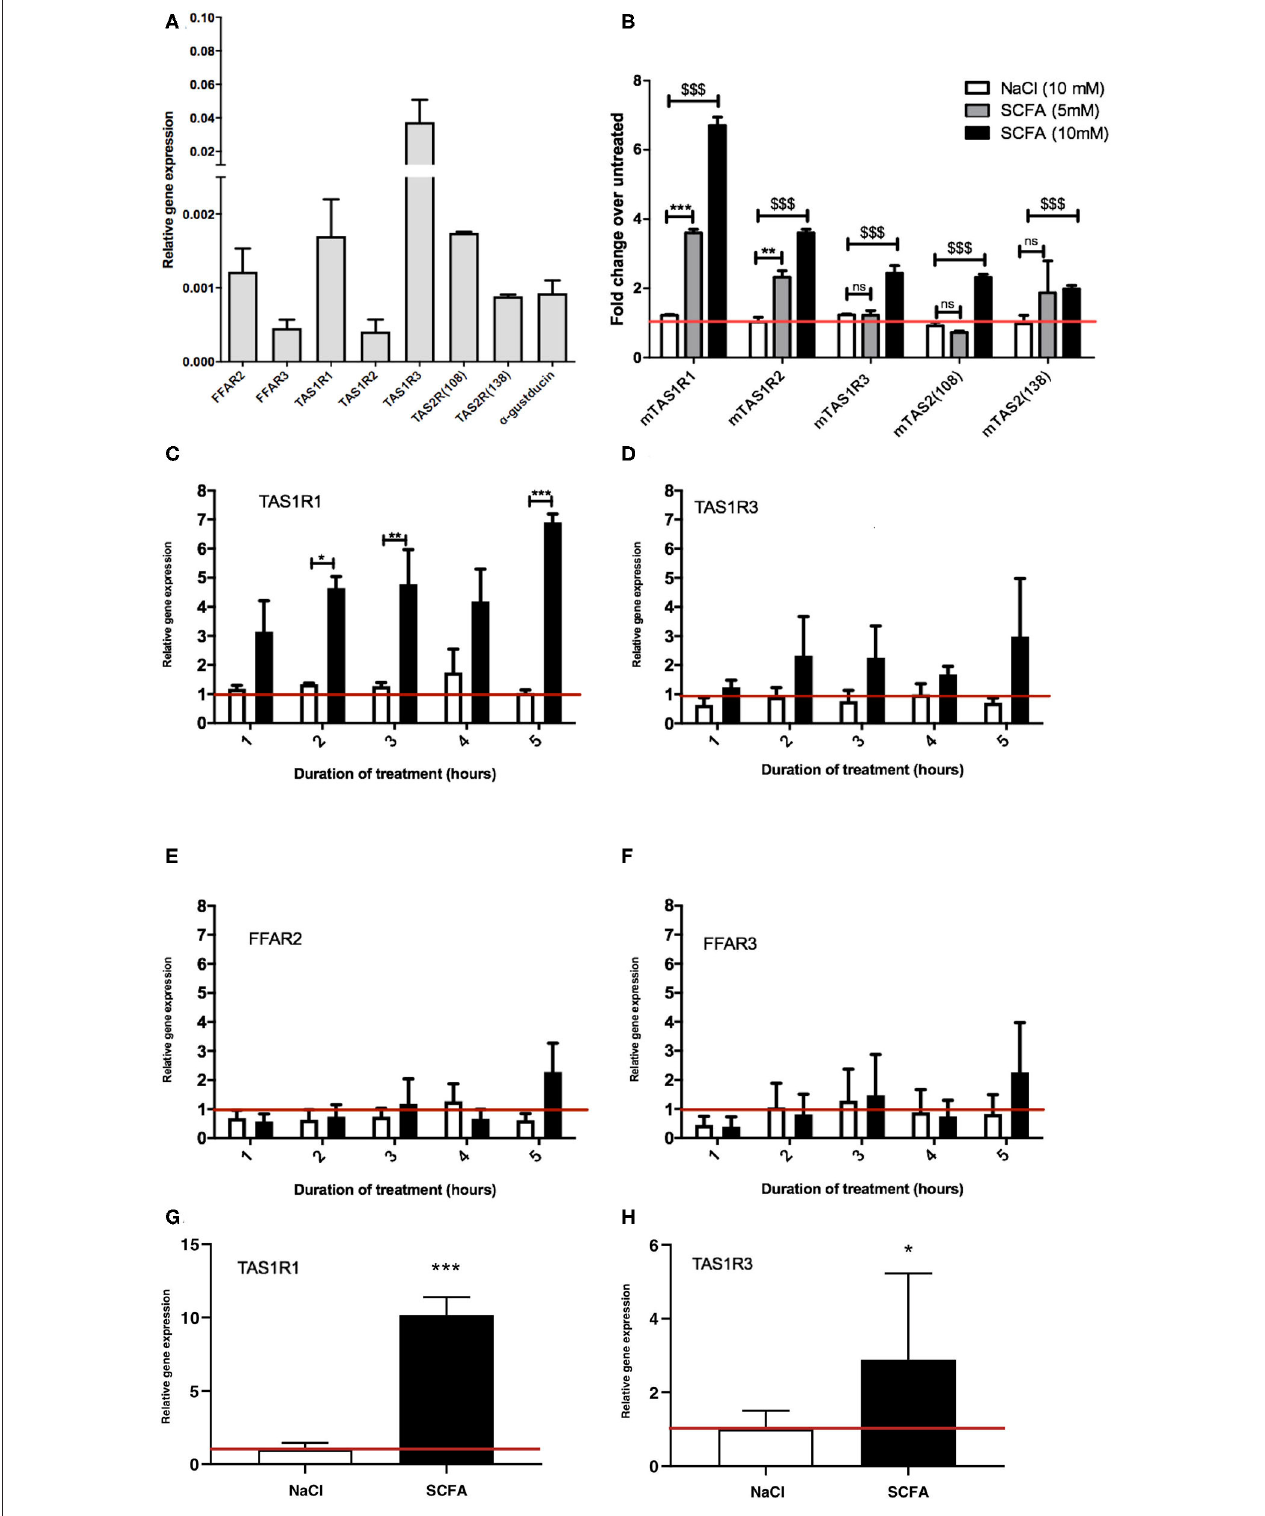
FIGURE 1 | Exposure to SCFAs significantly changes the expression profile of taste receptors in STC-1 cells. (A) RNA was extracted from STC-1 cells for qPCR analysis of taste receptors TAS1R1, TAS1R3, TAS1R2, TAS2 (108), and TAS2 (138); free fatty acids receptors FFAR2 and FFAR3; and taste-specific G-protein α -gustducin, and normalized to the levels of housekeeping gene β -actin. (B–G) STC-1 cells were treated with NaCl (control; white bars), 5mM SCFAs (gray bars), or